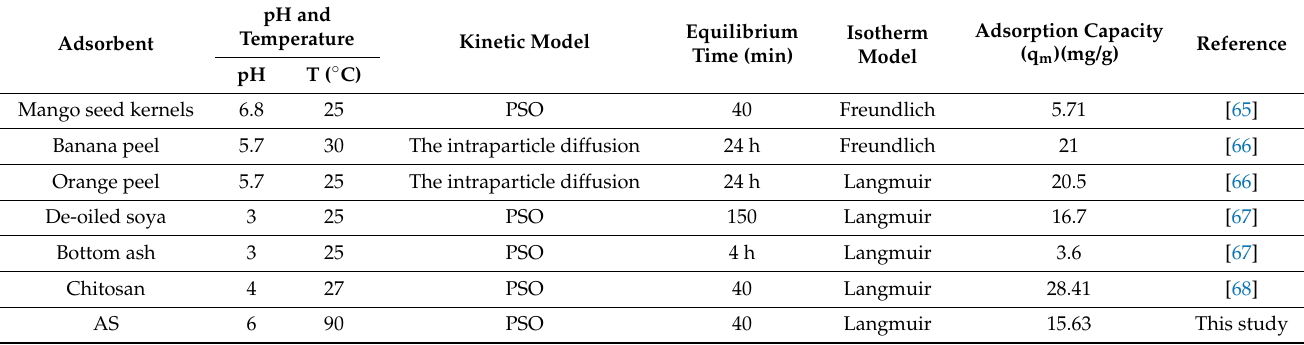
Table 4. MO adsorption capacity by different adsorbents in comparison with